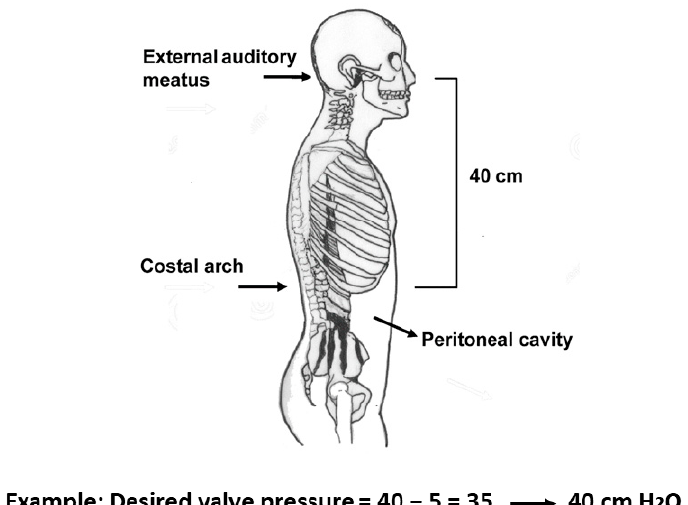
Figure 2. Method of selecting a suitable pressure for the high-pressure valve in the Miethke ® Dual-Switch valve. (1) Measure the distance between the third ventricle (external auditory meatus) and the patient’s diaphragm (costal arch); (2) subtract 5 cm from the measured distance; (3) choose a valve whose high-pressure setting exceeds the final measured value by the smallest amount.